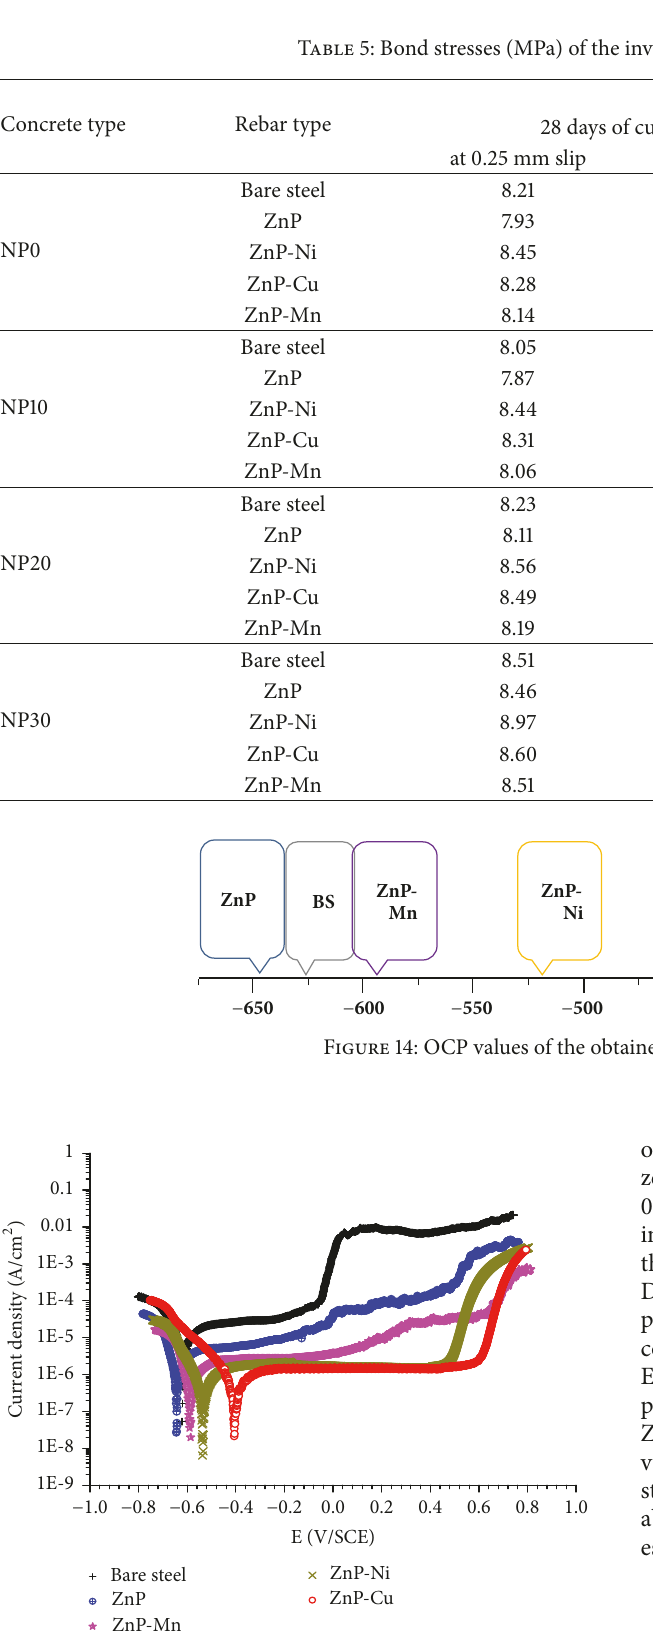
Figure 15: Polarization curves for zinc phosphate coating and bare steel after immersion in (CH-Cl)